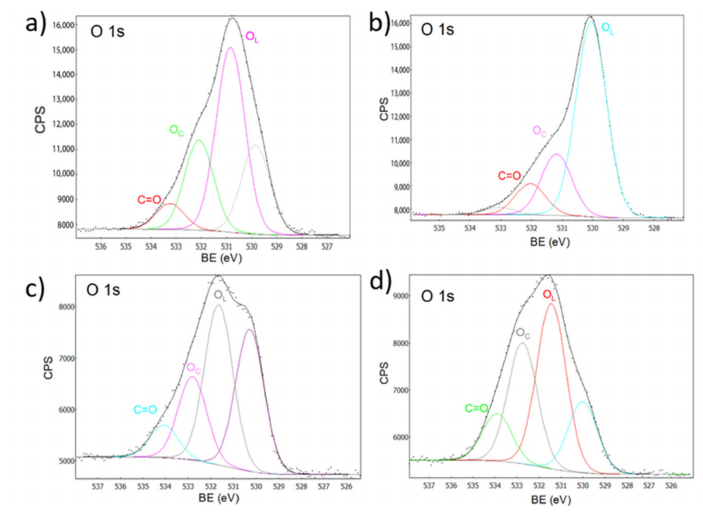
Figure 7. XPS spectra for oxygen. ( a ) ZnO, ( b ) Zn-Ca 1, ( c ) Zn-Ca 3, ( d ) Zn-Ca 5. The spectra for carbon (C 1s) is shown in Figure 8, where the peak deconvolutions at 289, 287, 285, and 284 correspond to O-C = C, C = O, C-O and C = C, respectively [48]. The spectra indicates a shift towards higher binding energies when calcium ions are used as a dopant [33,49].